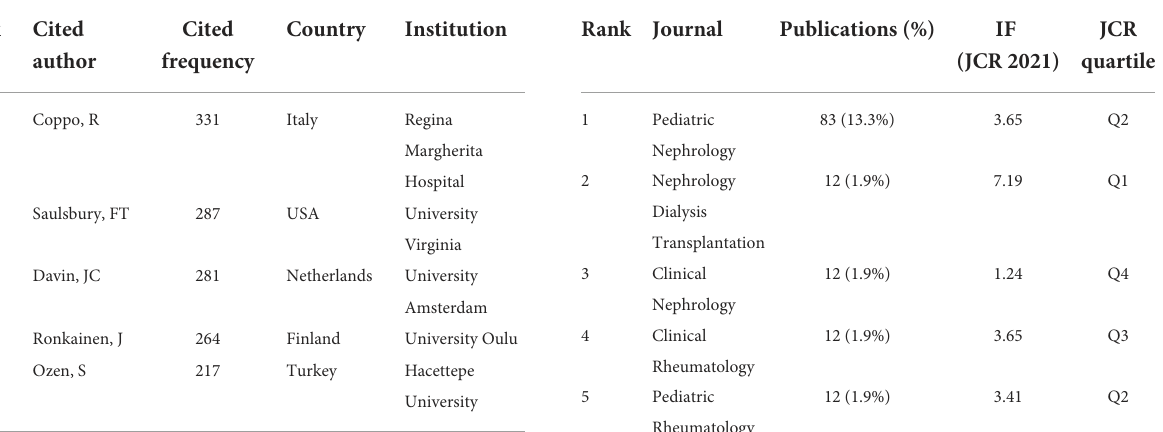
TABLE 4 The top 5 most publication cited authors. TABLE 5 The top 5 most publication